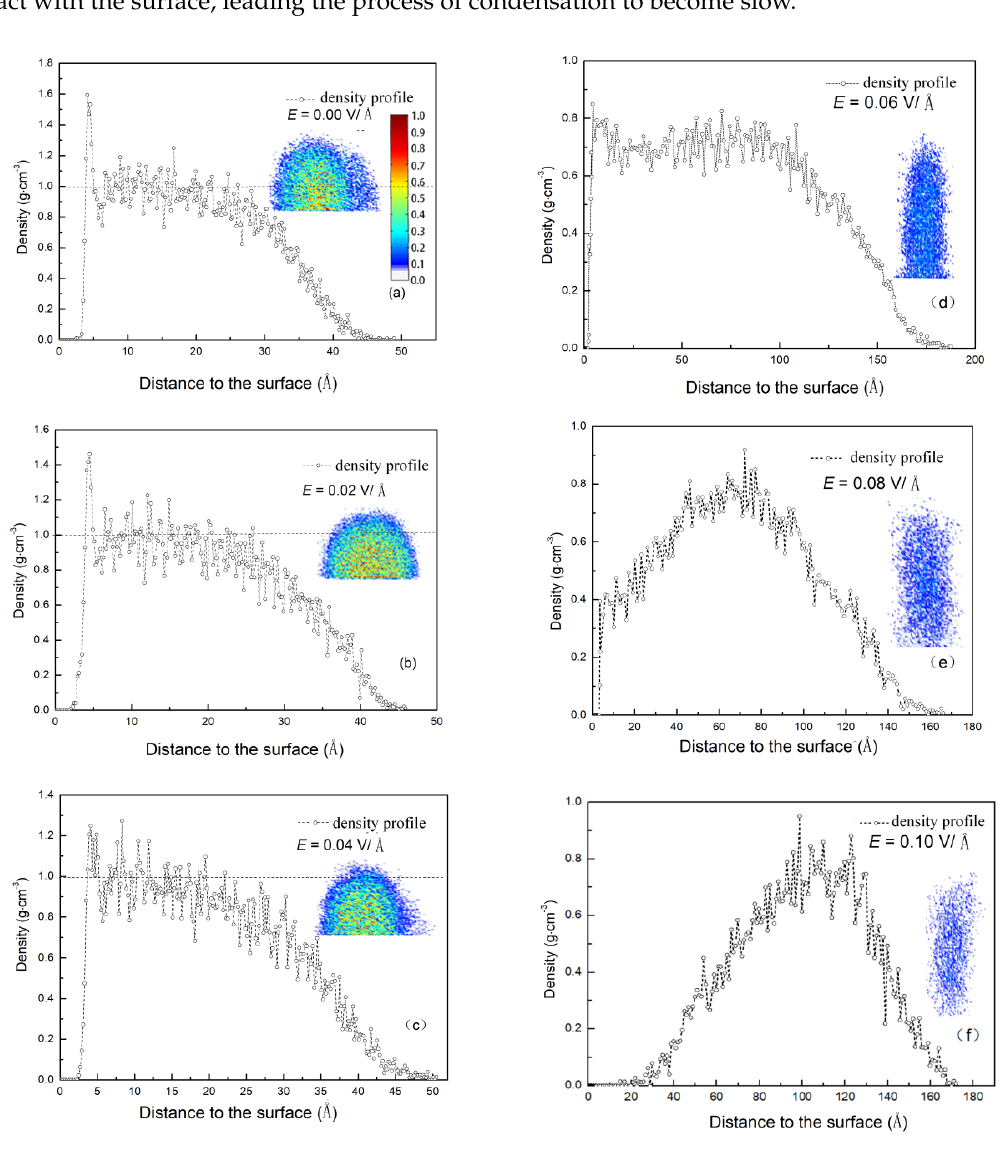
Figure 6. The density profiles of the largest cluster under different electric field strength along the centerline of the Z axis. ( a ) E = 0.00 V/Å; ( b ) E = 0.02 V/Å; ( c ) E = 0.04 V/Å; ( d ) E = 0.06 V/Å; ( e ) E = 0.08 V/Å; ( f ) E = 0.10 V/Å; The inset figures show the density contours, which is the middle cut of the largest cluster in the X-Y plane.